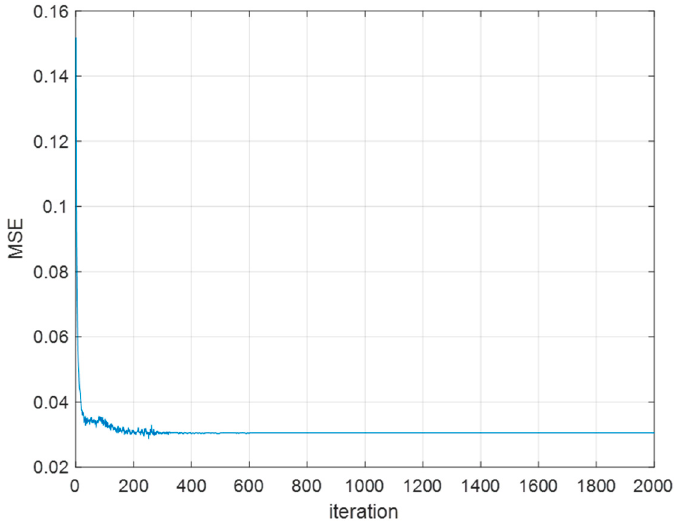
Figure 11. MSE value according to the number of repetitions applying MLP.